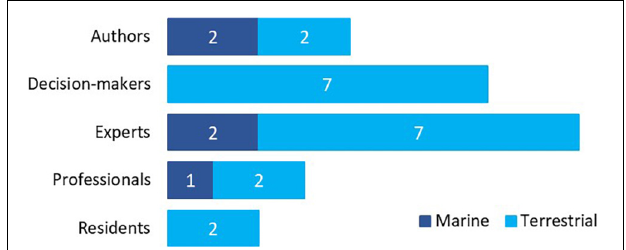
FIGURE 4 | Number of sources by MCDA methods.